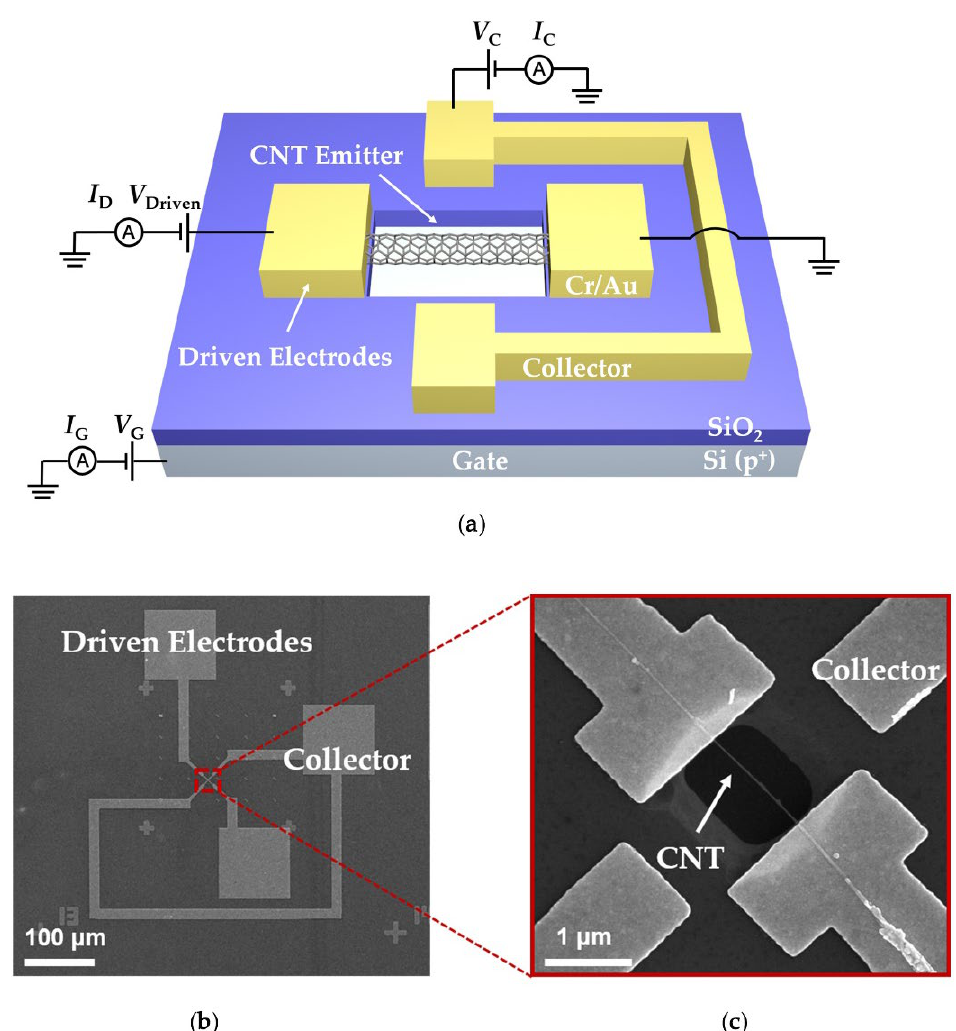
Figure 1. ( a ) A schematic illustration and working principles of a CNT-based vacuum transistor; ( b ) an SEM image of a global CVT; ( c ) an SEM image of the framed area in image ( b ). CNT-based vacuum transistors are fabricated on SiO 2 /Si wafer substrates by micro- fabrication technologies, where the SiO 2 layer thickness is 300 nm. The metallic multi- walled carbon nanotubes fabricated by arc discharge with a smooth surface and a perfect structure are dispersed on the substrate in alcohol solution. A proper carbon nanotube is selected first for device fabrication via SEM observation. The average diameter of selected